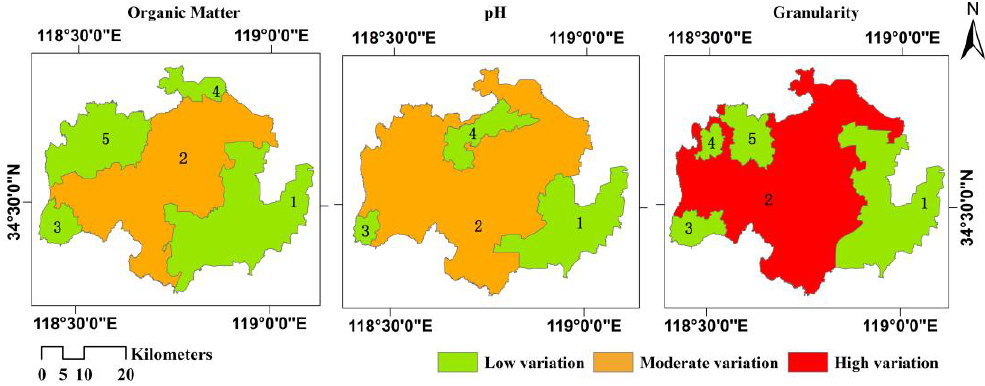
Figure 2. Spatial variation partitions of the three soil properties.